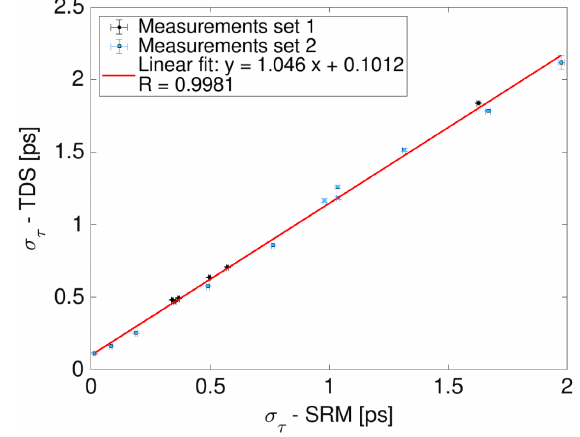
FIG. 5. Two independent batches of electron bunch length measurements by TDS and by SRM based